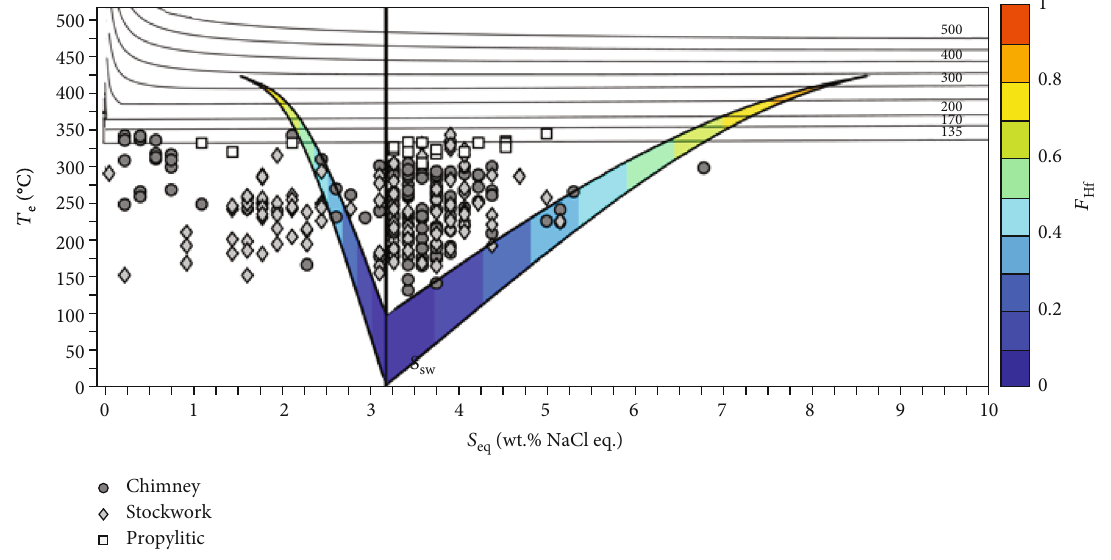
Figure 10: Mixing model 2. Salinity-temperature relation for isenthalpic mixing paths of mixtures between a supercritically phase-separated hydrothermal fl uid and ambient to heated seawater at 340 bar. High-salinity inclusions fall on this mixing